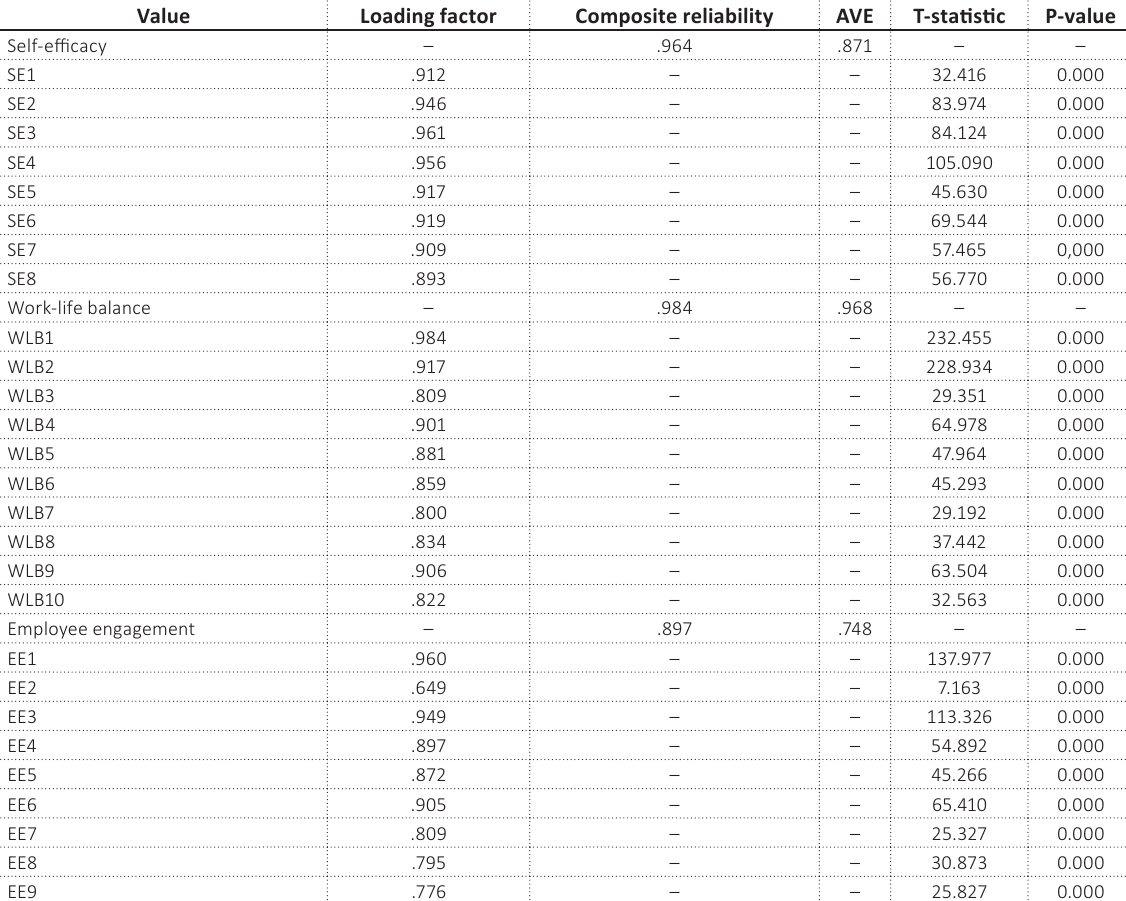
Table 3. Measured factors for validity and reliability instruments